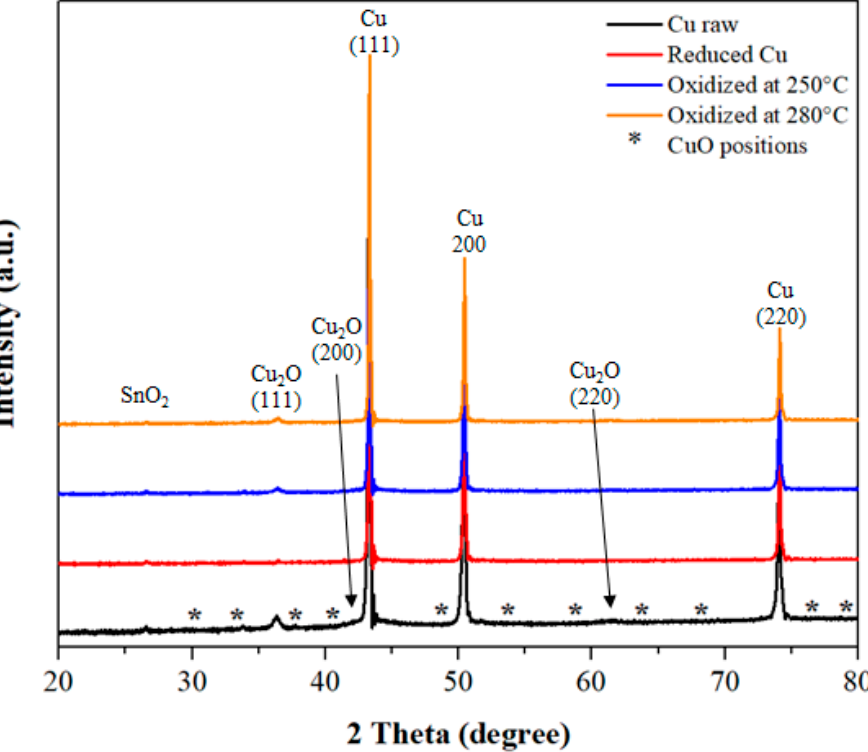
Figure 1. XRD patterns of raw, reduced and oxidized Cu powders.